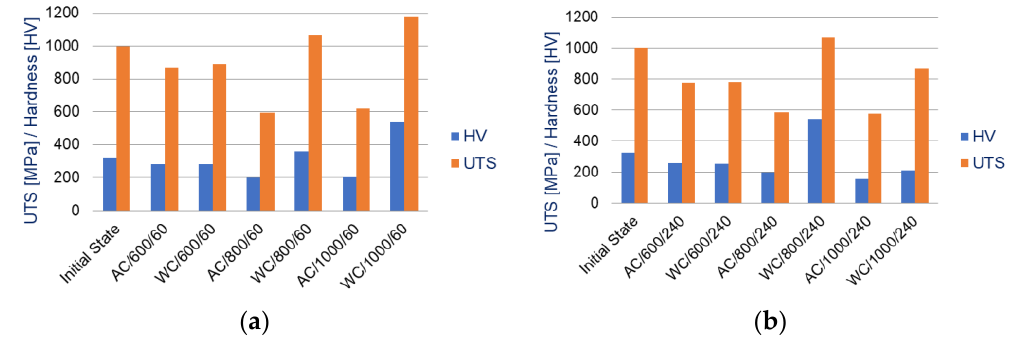
Figure 4. Diagram of dependencies between bolt steel hardness and bolt residual tensile strength on heating time for samples subjected to secondary heat treatment for the time of: ( a ) 60 min; ( b ) 240 min.